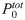
Results for the HF Model.(A, E, I) The temporal profiles of the response relaxation for different values of P0tot, P1tot, and P2tot. In Fig 5(A), we set P1tot and P2tot equal to their base values from Table A in S1 Appendix. We then integrated the HF model for each of the P0tot values taken from the set {P0tot,0,P0tot,1,…,P0tot,26,P0tot,27}={100.4,100.2,…,10−4.8,10−5.0}. (B, F, J) The consecutive similarity in the temporal profiles for P0tot, P1tot, and P2tot. In Fig 5(B), we computed the L2 norm in the difference between consecutive temporal profiles. The gray portion of the lines in (B, F, J) indicate that the system is in a deactivated state (i.e., g2 < 0.5) for those values of Pitot. (C, G, K) The half-life of the response as a function of P0tot, P1tot, and P2tot. The magenta triangle indicates when the Pitot value becomes the minimum Ptot value. The black dot represents the base Pitot value from Table A in S1 Appendix. The grayed out region indicates that the system is in a deactivated state for those values of Pitot. The region between the dashed vertical lines indicate that the logarithmic gain magnitude of the duration against Pitot is less than 0.3. The dashed green line is g2 as a function of βi. (D, H, L) The logarithmic gain of the duration against P0tot, P1tot, and P2tot.